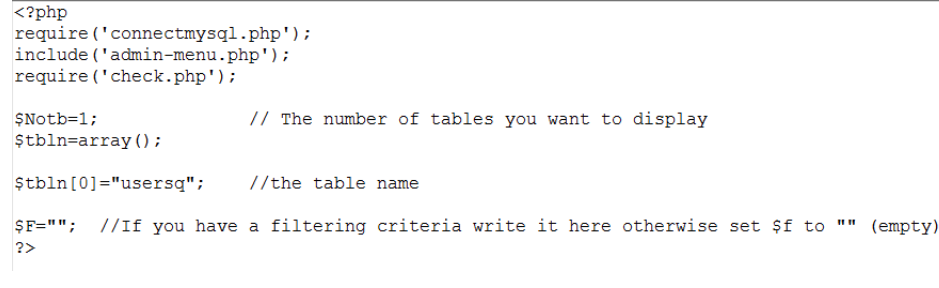
Figure 11. The parameters file for view users component.